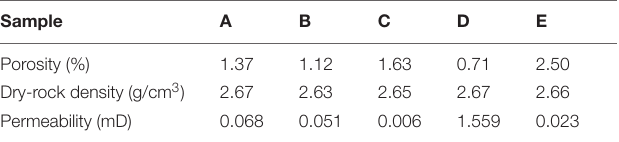
TABLE 1 | Properties of the limestone samples.